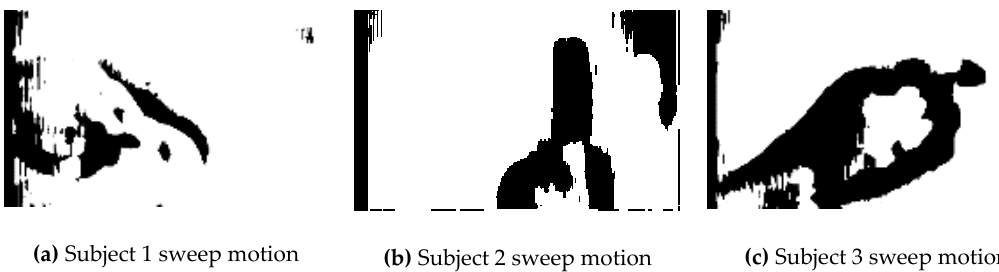
Figure 8. The disparity images of the Sweep motion for the three subjects.